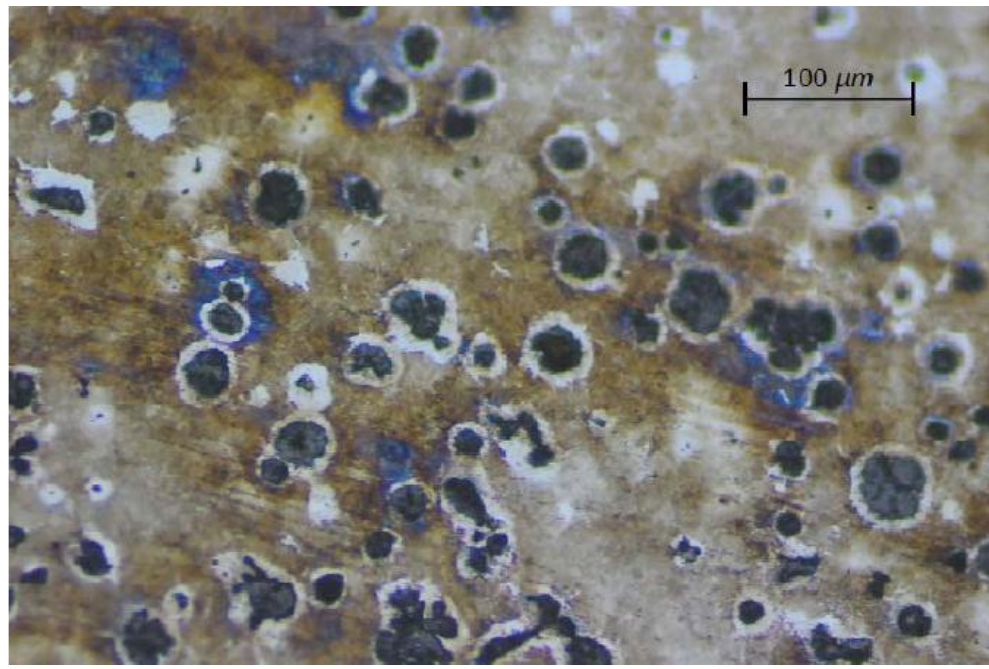
Metals 2016 , 6 , 283 8 of 14 Figure 4. Micrograph of the structure produced on the base material at the edge of the heat affected zone.